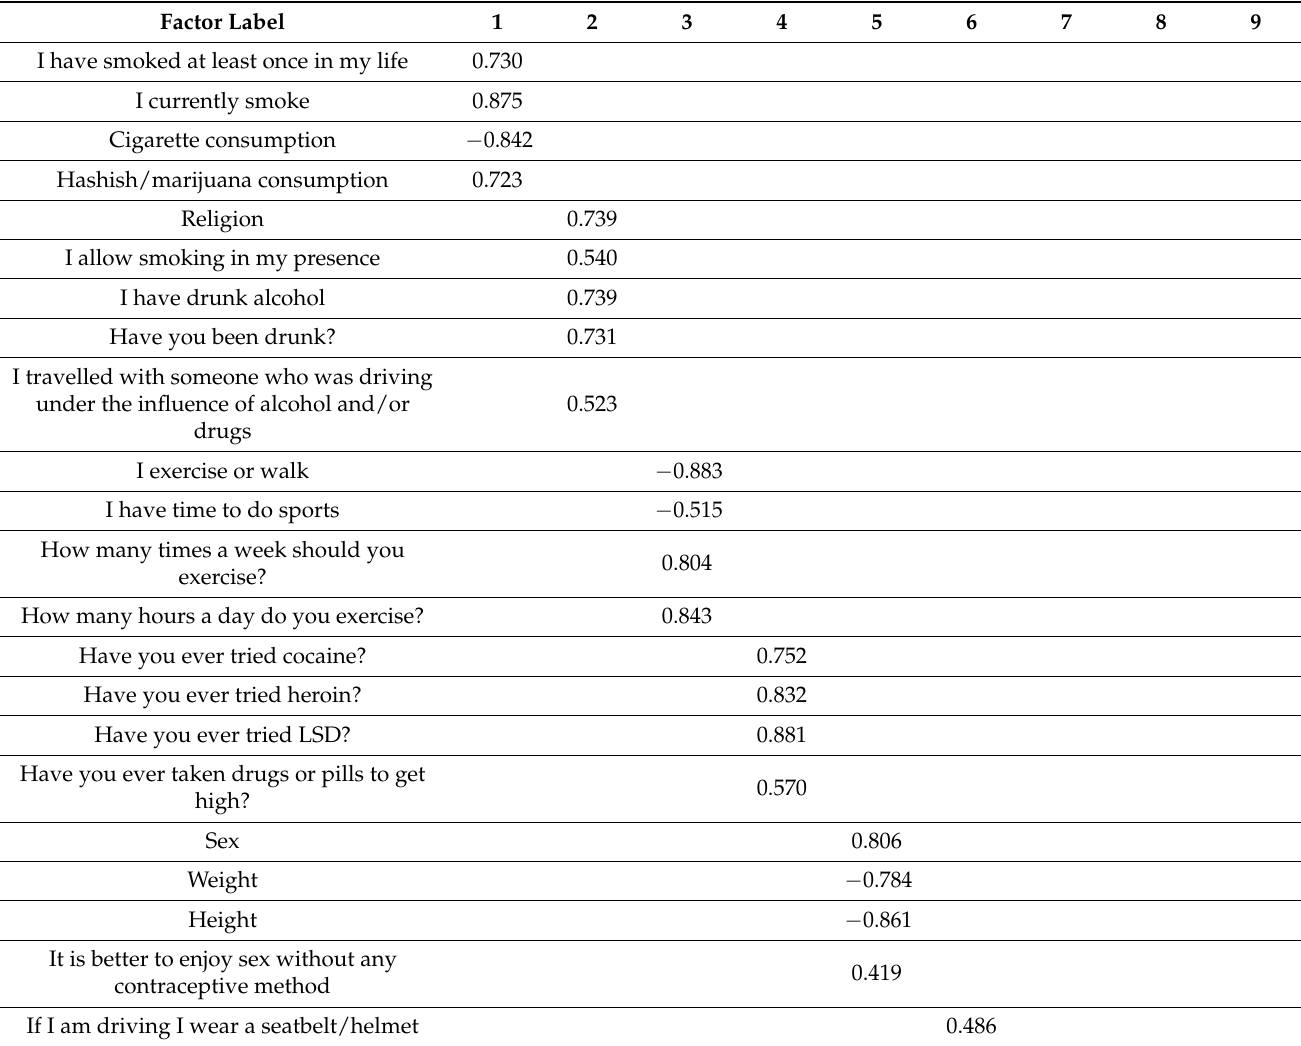
Table 5. Factor loadings (rotated component matrix of the principal component